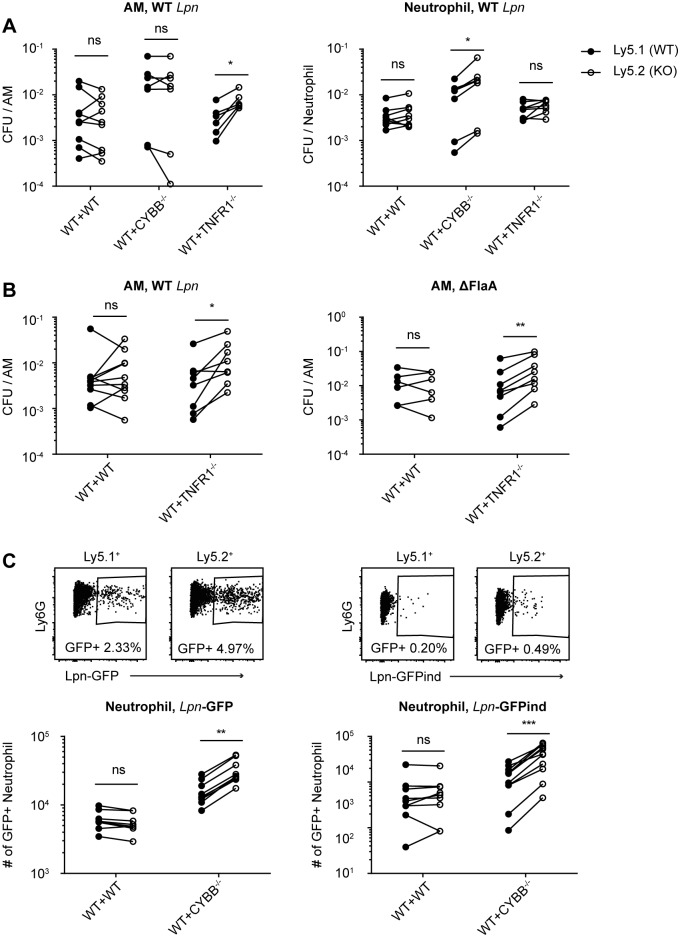
TNF / TNFR1 signaling contributes to AM-mediated killing of L. pneumophila, while ROS are required for efficient neutrophil-mediated killing in vivo.
(A-C) Mixed BM chimeric mice reconstituted with 50% Ly5.1+ WT BM, and either 50% Ly5.2+ WT, TNFR1-/- or CYBB-/- BM were generated. (A) Chimeras were infected with WT L. pneumophila, and 2 days p.i. BALF was harvested and Ly5.1+ and Ly5.2+ AM and neutrophils were sorted. Cells were lysed and CFU were quantified on CYE agar plates. (B) Chimeras were infected with WT or ΔFlaA L. pneumophila, and CFU were quantified in AM as in A). (C) Chimeras were infected with Lpn-GFP or Lpn-GFPind (with IPTG induction) and BALF was analyzed by flow cytometry 38 hr p.i.. GFP+ neutrophils were normalized for the number of Ly5.1+ and Ly5.2+ neutrophils, respectively. Data are from 2–4 pooled experiments. *p<0.05, **p<0.01, ***p<0.001 by Wilcoxon test.